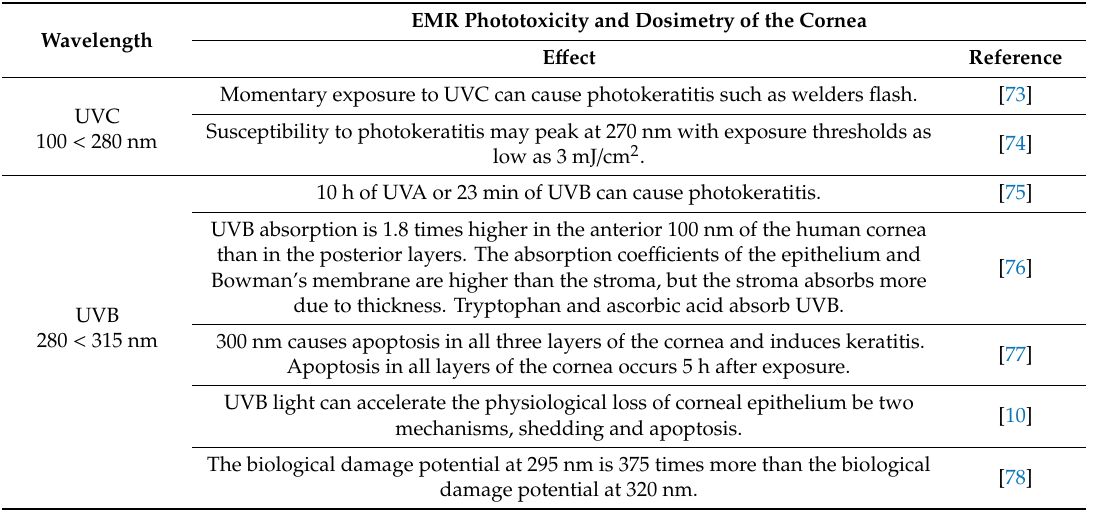
Table 2. Electromagnetic radiation action spectra and dosimetry thresholds for the cornea. EMR Phototoxicity and Dosimetry of the Cornea Wavelength E ff